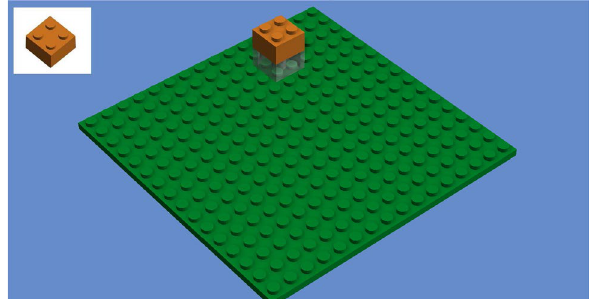
Figure 6. Pictorial representation of a placement action in the Duplo assembly study. The transparent placeholder brick indicated that the new orange brick must be added on top of another brick at the same X,Y position. The QSplit user interface for the SDA-M split procedure also showed a simple textual description of the action ( “Placing a small orange brick”